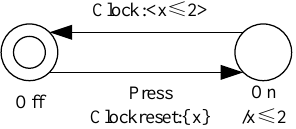
Figure 1. An example of a Timed